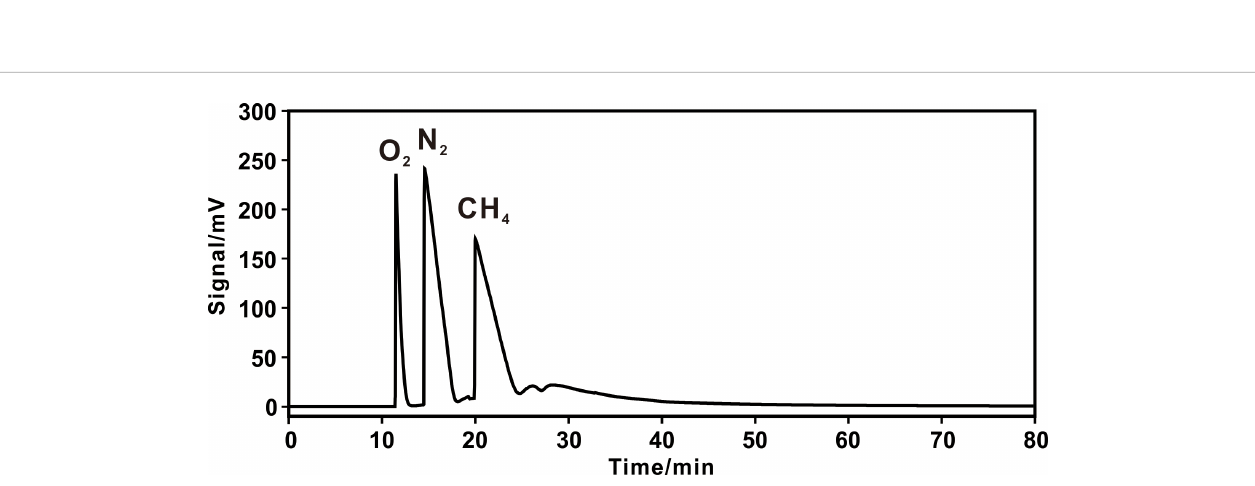
FIGURE 5 Chromatogram of 50% methane+50% air on 3,2,1/8 columns. A constant temperature procedure of 25 °C was